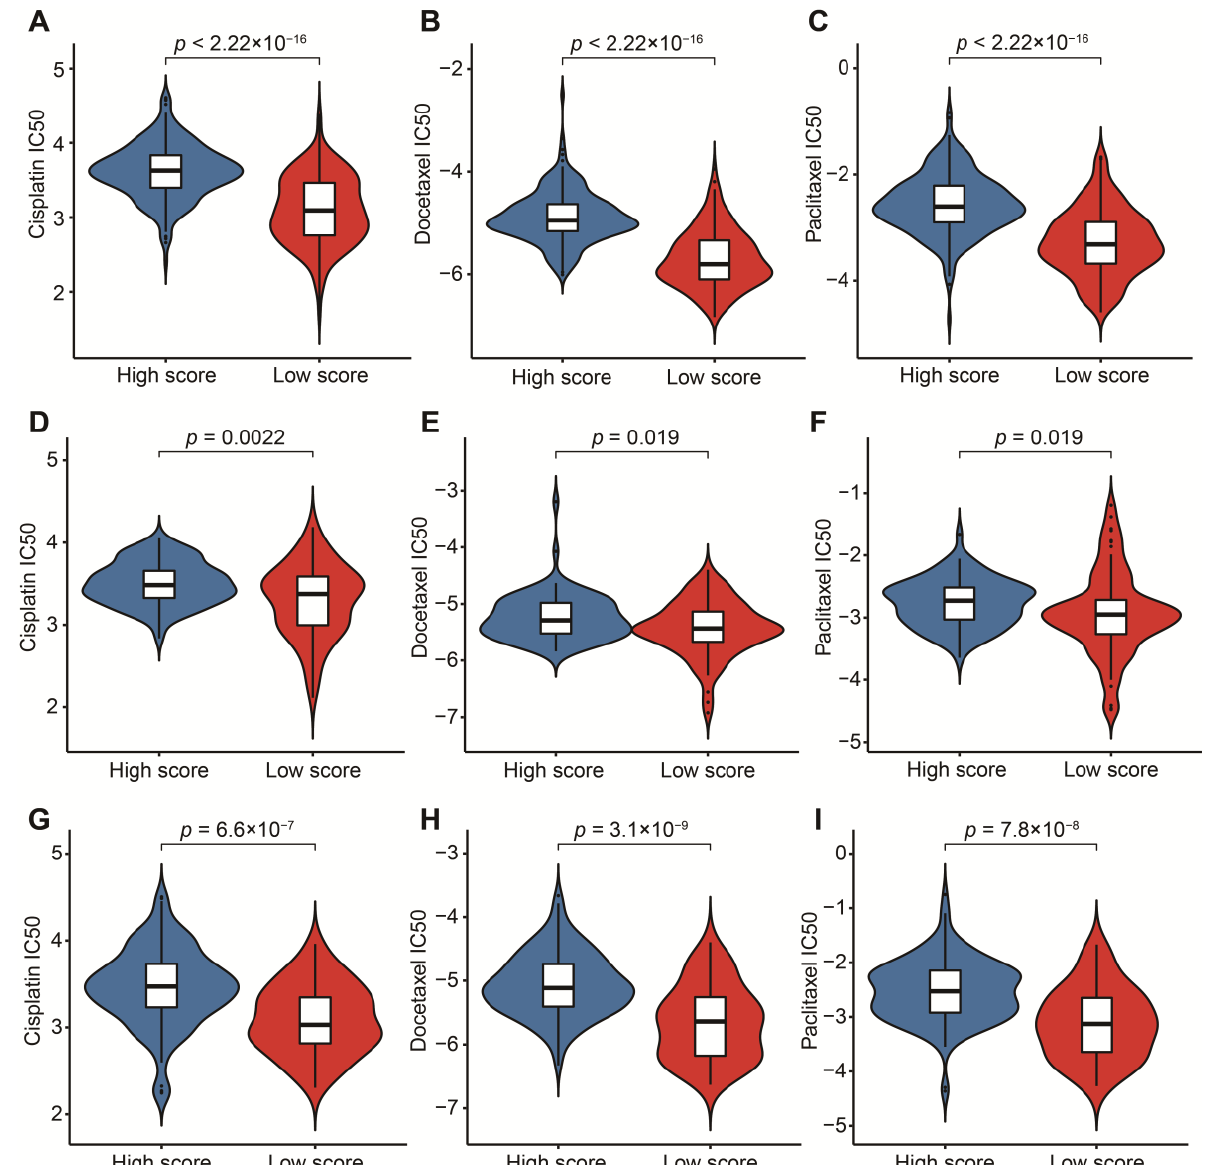
Figure 9. Prediction of sensitivity to three chemotherapeutic drugs. ( A ) Comparison of cisplatin IC50 between high- and low-score groups in the TCGA-BLCA dataset. ( B ) Comparison of docetaxel IC50 between high- and low-score groups in the TCGA-BLCA dataset. ( C ) Comparison of paclitaxel IC50 between high- and low-score groups in the TCGA-BLCA dataset. ( D ) Comparison of cisplatin IC50 between high- and low-score groups in the GSE13507 dataset. ( E ) Comparison of docetaxel IC50 between high- and low-score groups in the GSE13507 dataset. ( F ) Comparison of paclitaxel IC50 between high- and low-score groups in the GSE13507 dataset. ( G ) Comparison of cisplatin IC50 between high- and low-score groups in the IMvigor210 cohort. ( H ) Comparison of docetaxel IC50 between high- and low-score groups in the IMvigor210 cohort. ( I ) Comparison of paclitaxel IC50 between high- and low-score groups in the IMvigor210 cohort.